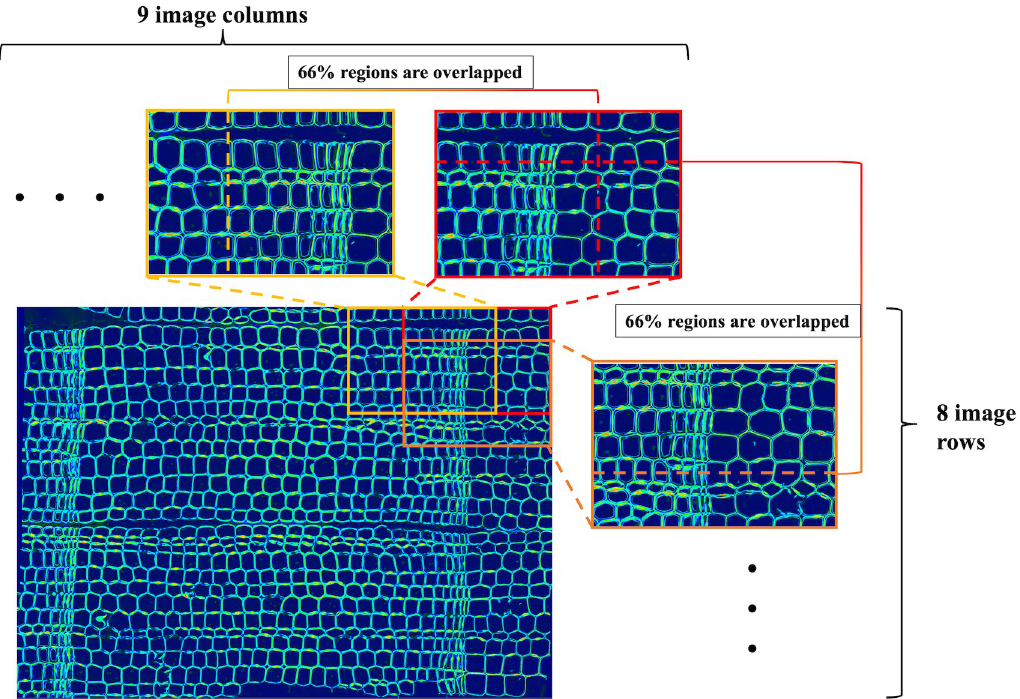
Fig 2. Example of image concatenation applied to a set of retardation images. The reconstructed retardation image comprised 72 partly overlapping retardation images in total (9 columns × 8 rows). Each image contained 66% overlapping regions with adjacent image patches in the horizontal and vertical